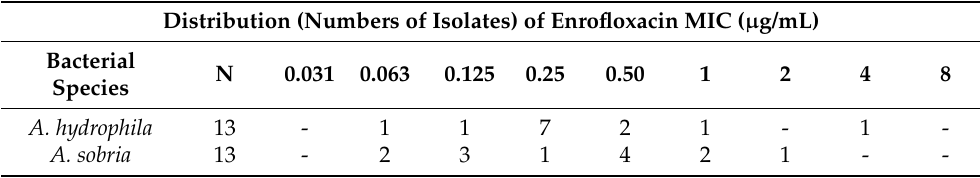
Table 2. MIC values of enrofloxacin for A. hydrophila and A. sobria isolated from fish farm. Distribution (Numbers of Isolates) of Enrofloxacin MIC ( µ